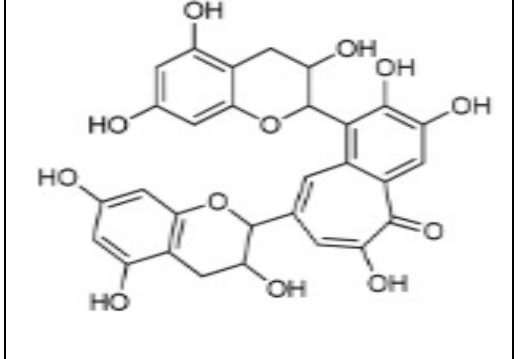
Figure 7. Chemical structure of theaflavin (72) Glycyrrhizin